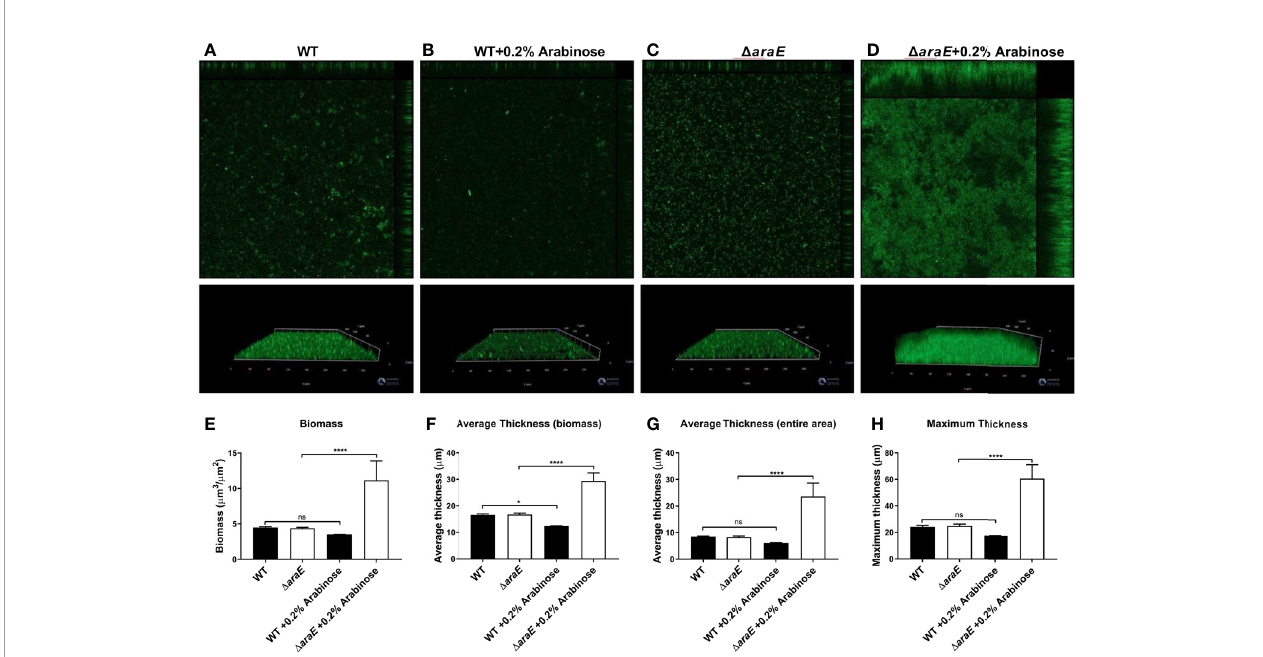
FIGURE 2 | L-arabinose bio fi lms visualized by confocal microscopy. WT 14028 (A, B) and D araE (C, D) GFP-expressing strains were grown in 96-well plates in 100 µL 1:20 TSB (black bars) or 1:20 TSB with 0.2% L-arabinose (white bars). After 24 hours, planktonic cells were removed, then bio fi lms were washed, fi xed in 2% paraformaldehyde, and bio fi lm structure was determined by GFP signal detection. Five random Z-stacks were captured per well and analyzed for biomass (E) , average thickness (F, G) , and maximum thickness (H) by COMSTAT2. Data are mean ± SD, statistical analyses were done using a two-way ANOVA with Dunnett ’ s multiple comparisons test NS, not signi fi cant ( P > 0.05); * P < 0.05; **** P <